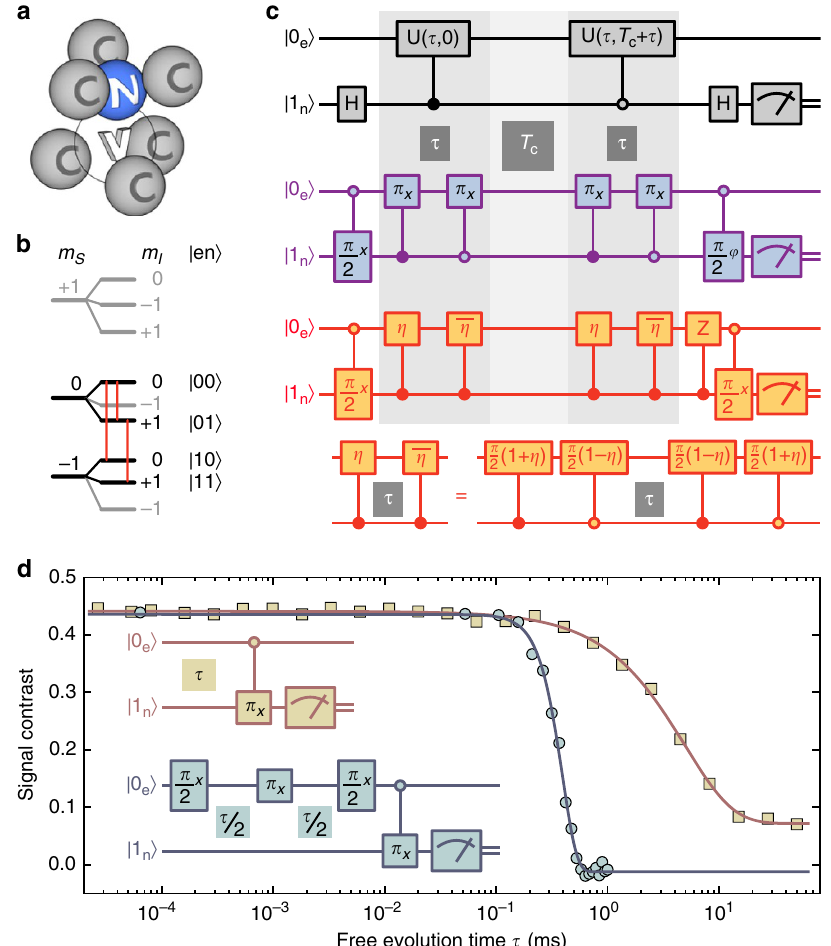
Figure 1 | System parameters and measurement sequence. ( a ) Structure of an NVdefect centre in diamond 45 . Two adjacent lattice sites are occupied by a nitrogen atom and a vacancy. ( b ) Energy-level structure of NV electron spin e ( S ¼ 1) and hyperfine coupled 14 N nuclear spin n ( I ¼ 1). Four out of nine spin states form the two-qubit basis-states en j i . They are eigenstates to electron spin operator S z and nuclear spin operator I z with respective magnetic quantum numbers m S and m I (see the ‘Methods’ section). Addressed spin transitions are marked with vertical red lines. ( c ) Quantum wire diagrams for quantum phase correlation measurements. Grey indicates general idea. Two quantum gates U t ; t ð Þ controlled by the memory qubit state represent our phase estimation steps with duration t at times t (that is, with separation T c ) . Filled (open) circles indicate 1 j i(cid:3) 0 j i(cid:3)ð Þ controlled gates. If both quantum gates are equal, the total phase on the memory is zero. Purple indicates the enhanced sequence with full entanglement of sensor and memory. Experimental implementation using controlled spin rotations (for example, p /2-pulses and p -pulses) of the sensor (memory) controlled by the memory (sensor) and free evolution times t and T c . Orange indicates sequences with variable degree of entanglement between sensor and memory realized via the Z - and (cid:2) Z -gate (see the ‘Methods’ section). ( d ) Measurements of the electron spin’s T 1 and T 2 time via measurement of the spin state population decay and a spin echo measurement (squares and circles). The inset shows the quantum wire diagrams of the respective measurement sequences. The signal is the probability of detecting the memory spin state 1 j i and the contrast is the difference of two signals with the final p -pulse on the memory controlled by the 0 j i and 1 j i state of the sensor. NATURE COMMUNICATIONS|7:12279|DOI: